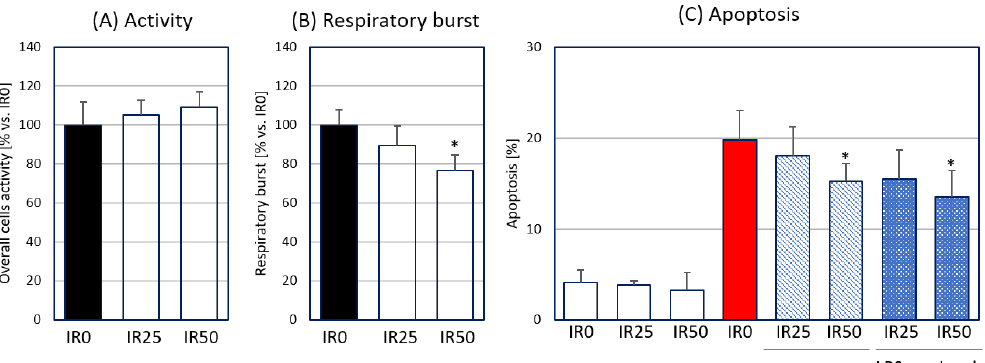
Figure 2. The effect of irisin (IR; 0, 25, or 50 nM) on RAW 264.7 macrophages in terms of overall activity and viability: ( A ) cell activity measured using the CellTiter test; ( B ) respiratory burst generation by macrophages stimulated with phorbol 12-myristate 13-acetate (PMA; free-radical production) measured 45 min after PMA stimulation; ( C ) apoptosis intensity measured with the Annexin V kit 24 h after lipopolysaccharide (LPS; 100 ng/mL) stimulation in the presence of IR administered 2 h before and 2 h after LPS treatment. Results are presented as the percentage vs. the IR0 + LPS group with standard deviation; n = 4–5. Statistically significant differences were calculated in relation to the IR0 + LPS group, used as a control group: * p < 0.05.